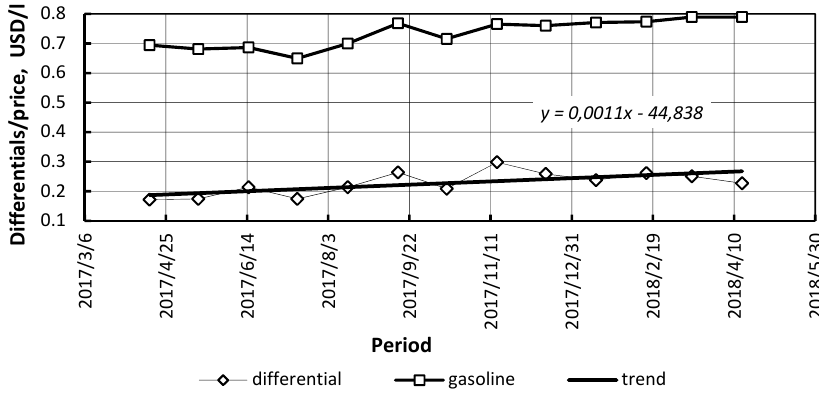
Figure 3. Fuel price differentials (the difference between gasoline and E85 prices) in the USA.